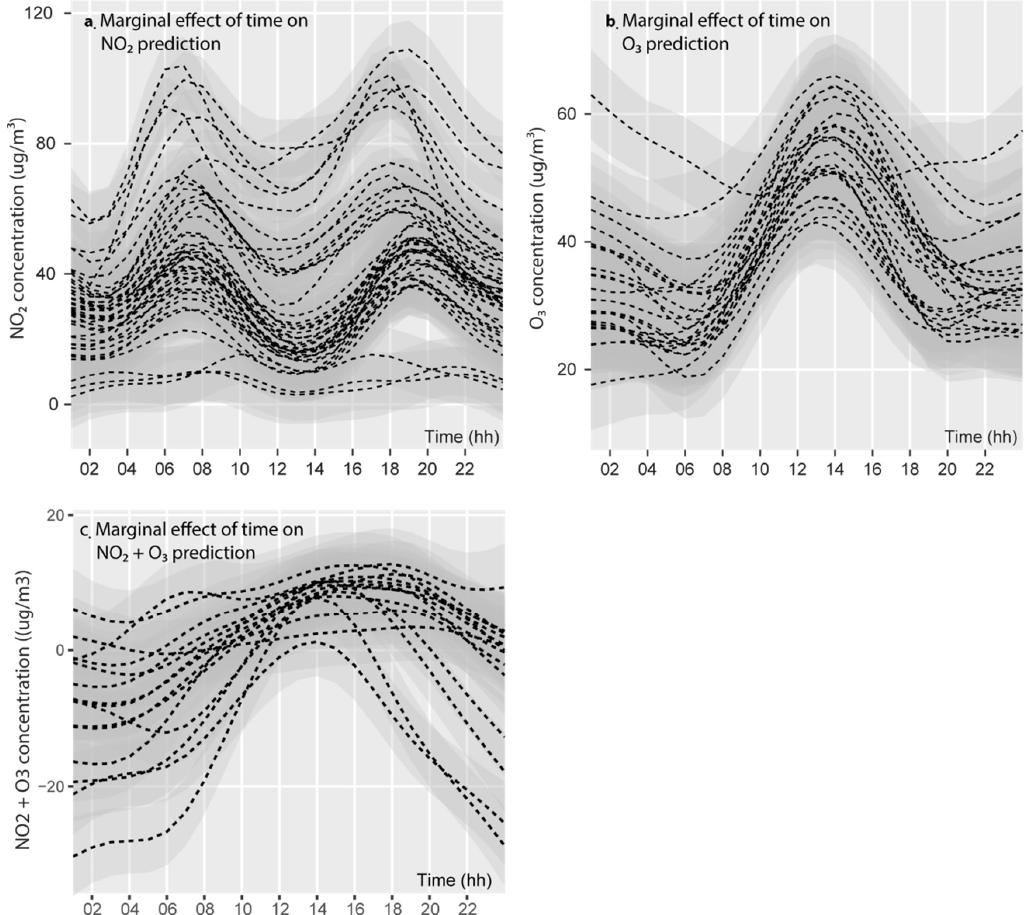
Figure 6. Modelled temporal trends of NO 2 and O 3 from AirParif monitoring stations for September 2017. ( a ) Marginal e ff ect of time on NO 2 prediction; ( b ) Marginal e ff ect of time on O 3 prediction; ( c ) Marginal e ff ect of time on NO 2 + O 3